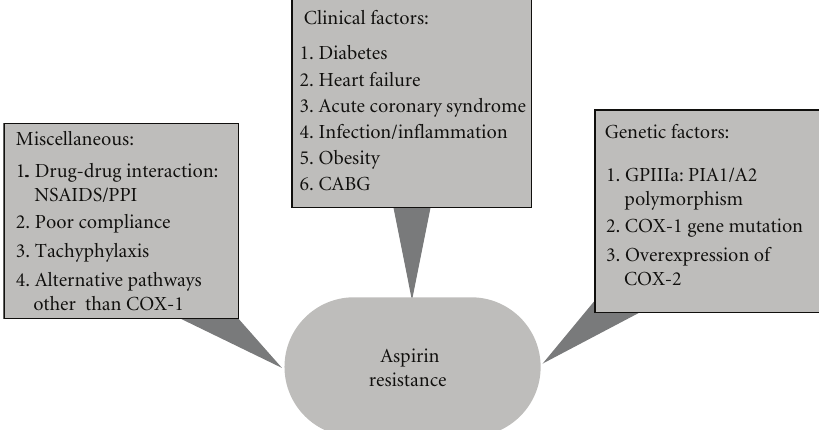
Figure 1: Proposed factors contributing to aspirin resistance (CABG: coronary artery bypass grafting; COX: cyclooxygenase; NSAIDS: nonsteroidal anti-inflamatory drugs; PPI: proton pump